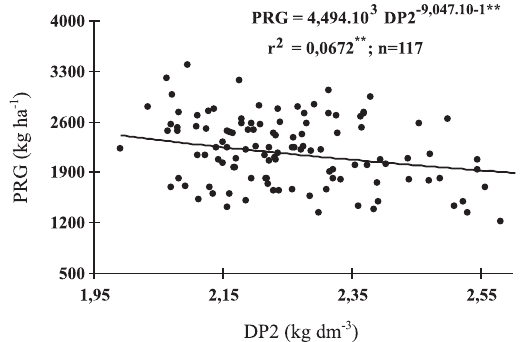
Figura 1. Equação de regressão entre a produtivida- de do feijão (PRG) e a densidade de partícula (DP2) de um Latossolo Vermelho distroférrico de Selvíria